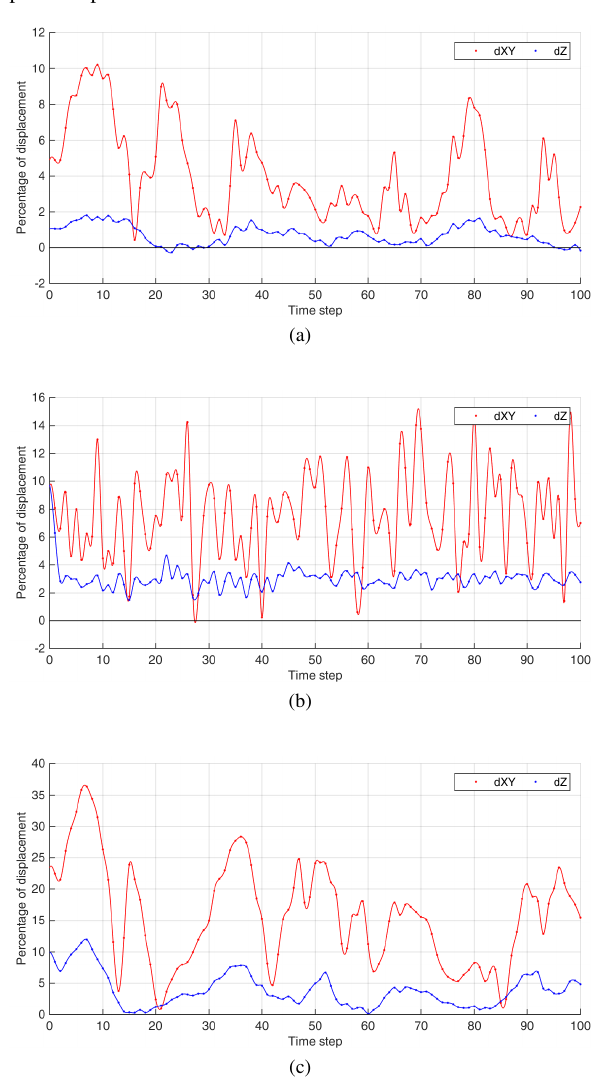
Figure 3: Percentage of coordinate displacement depending on water depth for (a) sea swell Υ 1 (d XY =7.5%, max. 14.8%; d Z =3.0%, max. 6.3%), (b) sea swell Υ 2 (d XY =4.0%, max. 10.2%; d Z =0.7%, max. 1.8%) and (c) sea swell Υ 3 (d XY =15.8%, max. 36.4%; d Z =3.9%, max.